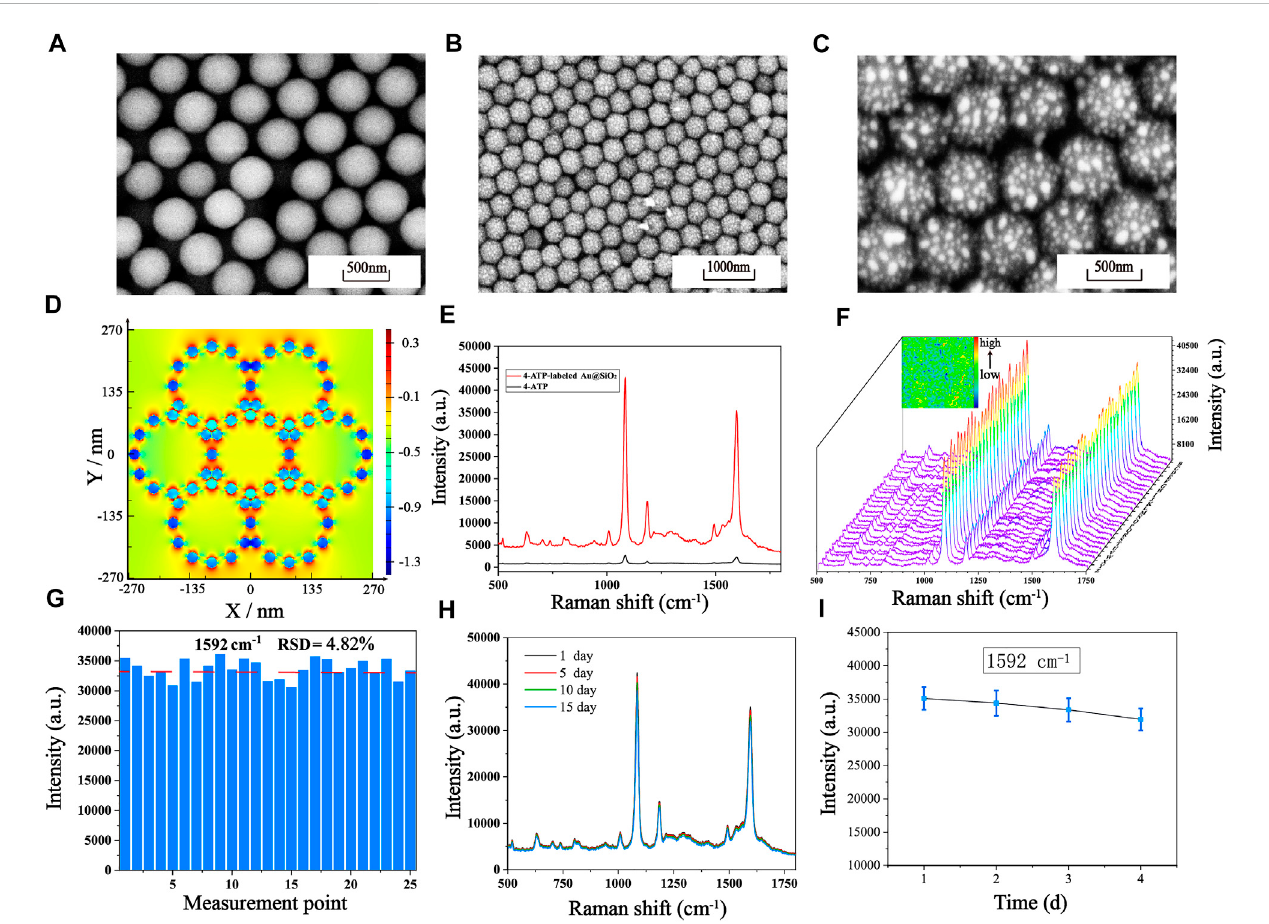
FIGURE 2 (A) Single-layer SiO 2 colloidal crystal fi lms. SEM images of the Au@SiO 2 array substrate at different magni fi cations: (B) Low magni fi cation. (C) High magni fi cation. (D) The simulated electric fi eld intensity distribution images of the array substrate from the upper view (E) SERS spectra of pure 4-ATP and 4- ATP-labeled Au@SiO 2 . (F) SERS mapping of the 4-ATP-labeled Au@SiO 2 array substrate and SERS spectra of 25 measurement points on the Au@SiO 2 array substrate. (G) ThecorrespondingSERSintensitydistributionoftheRamanabsorptionpeakat1,592 cm − 1 . (H) Afterstorageatroomtemperaturefor1 day, 5 days, 10 days and 15 days, the average SERS spectra of the 4-ATP-labeled Au@SiO 2 . (I) The corresponding line graph of the signal strength at 1,592 cm − 1